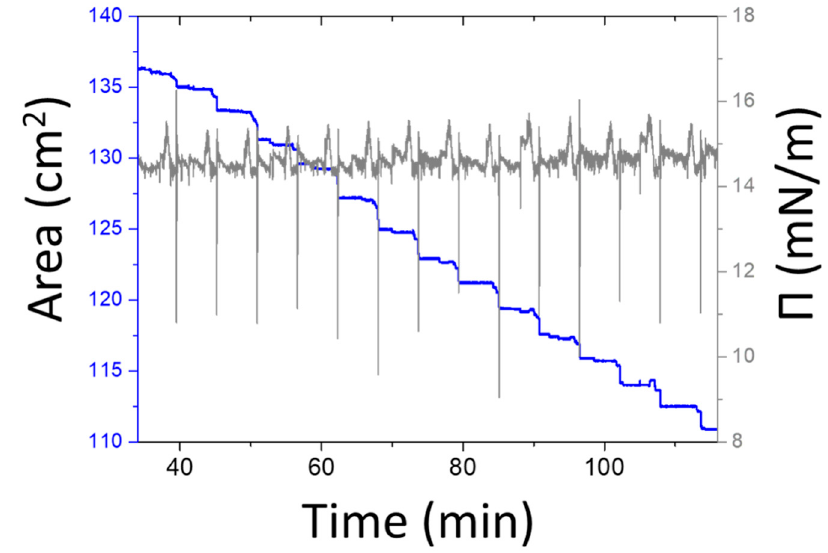
Figure 1. Langmuir Schaefer deposition of a DODA-clay-Fe / POSS hybrid film. The blue curve represents the trough area covered by the Langmuir film; the grey curve denotes the change of the surface pressure throughout the whole deposition.